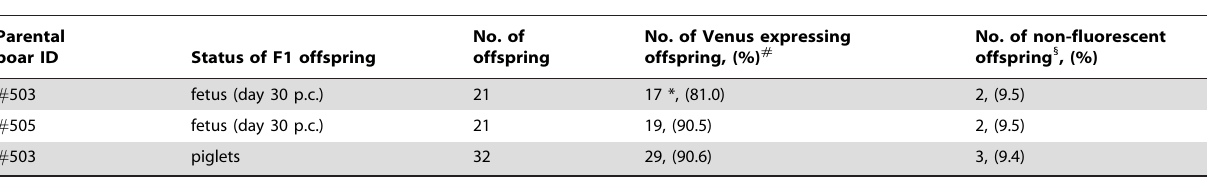
Table 5. Phenotypes and genotypes of